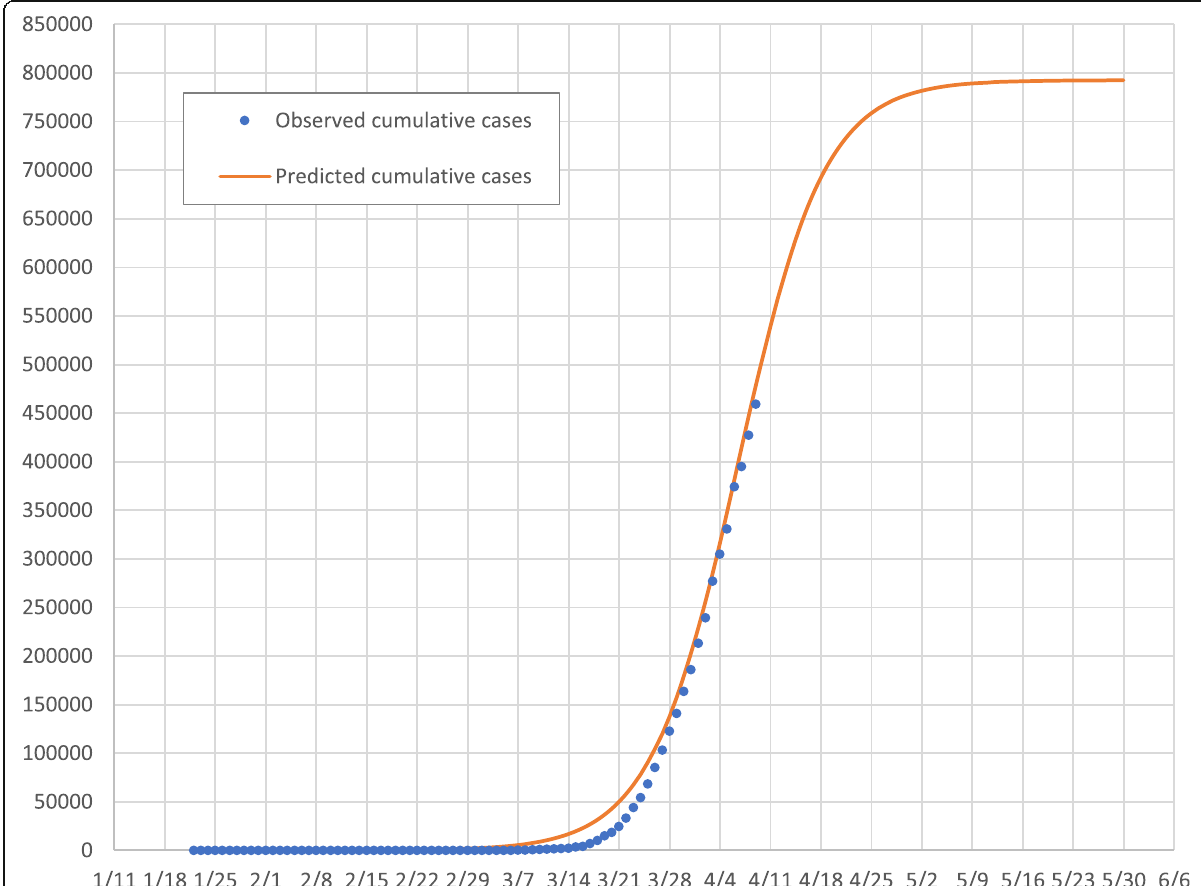
Fig. 2 Observed vs. model-estimated and forecasted daily cumulative COVID-19 cases, January 22 – May 30,